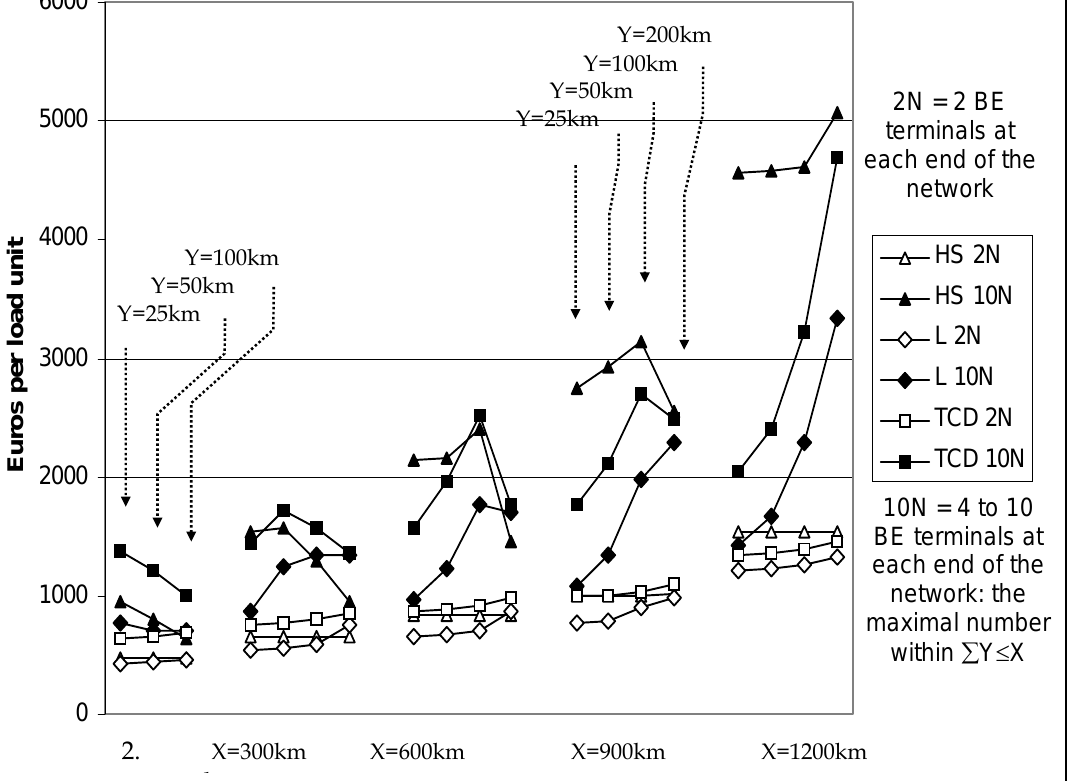
Figure 6. Network-averaged rail costs per load unit (Euros) in HS-, L- and TCD networks. Network transport volume =